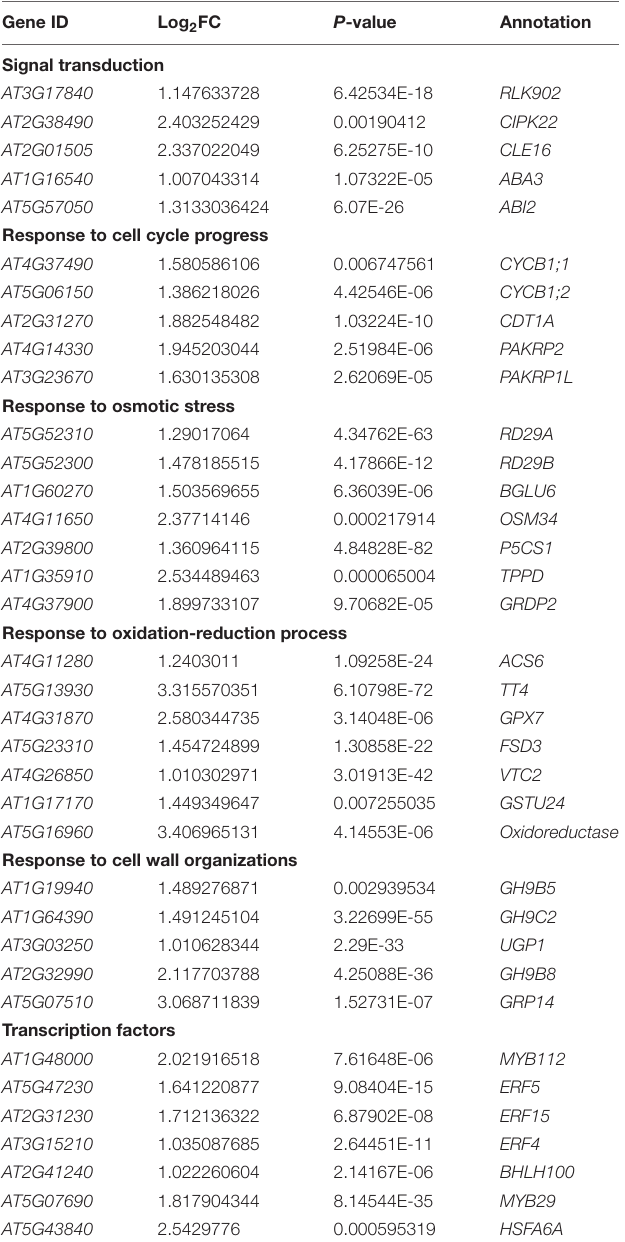
TABLE 2 | Expression levels of DEGs from different biological processes in HN vs.